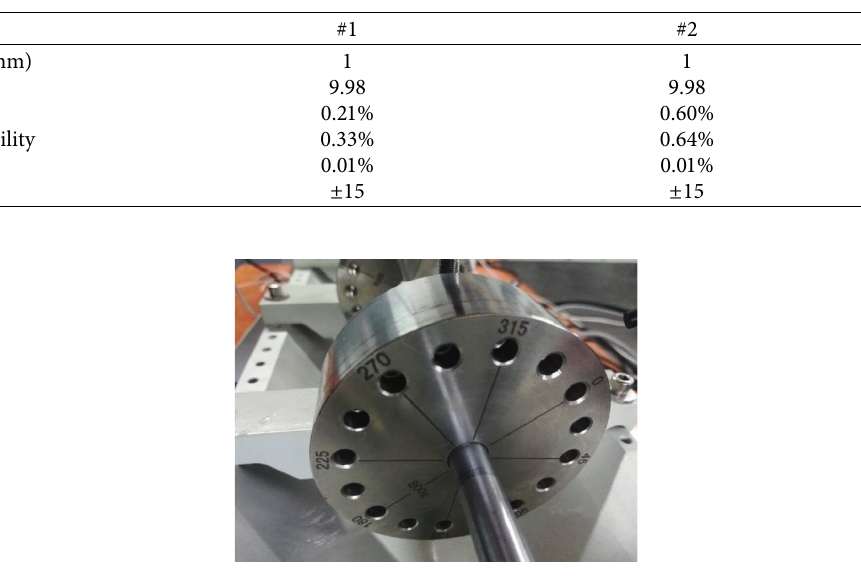
Figure 3: The setup of the rotor experimental system. Table 1: Eddy current sensor parameters.